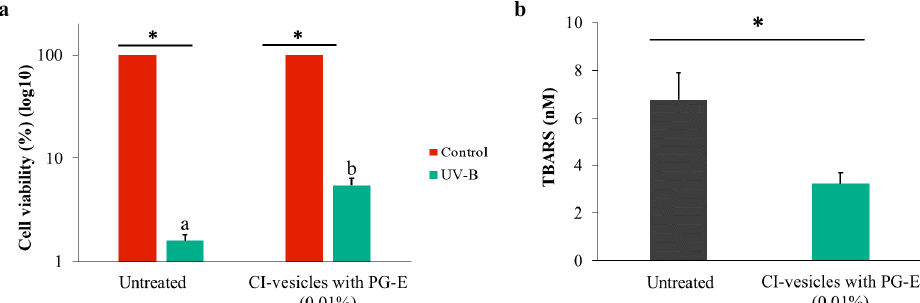
Figure 7. Viability of HaCaT cells after UV-B exposure, determined by the MTT assay. The results were normalized as a function of the control cytotoxicity ( a ). TBARS (thiobarbituric acid reactive substances, nM) was released into the culture medium by HaCaT cells ( b ). The HaCaT cells were exposed to UV radiation after treatment for 24 h with cauliflower inflorescence vesicles (CI-vesicles) with pomegranate extract (PG-E) (0.01%). Data are means ± SE ( n = 6). Different letters indicate significant differences between groups. *, significant differences compared to the respective control ( p < 0.05).